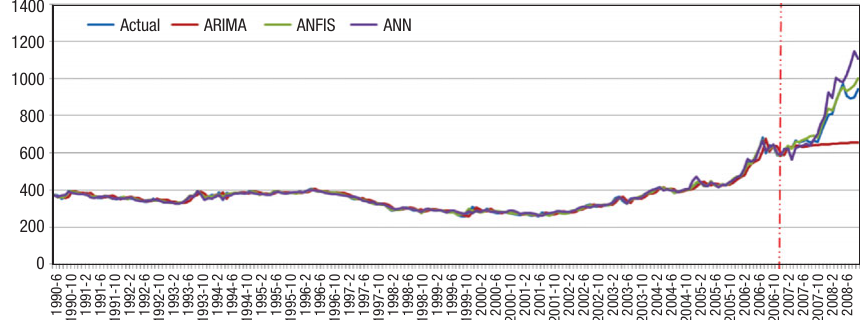
Fig. 6. Actual and forecasted values during training and validation by ARMA, ANN, and ANFIS for gold price